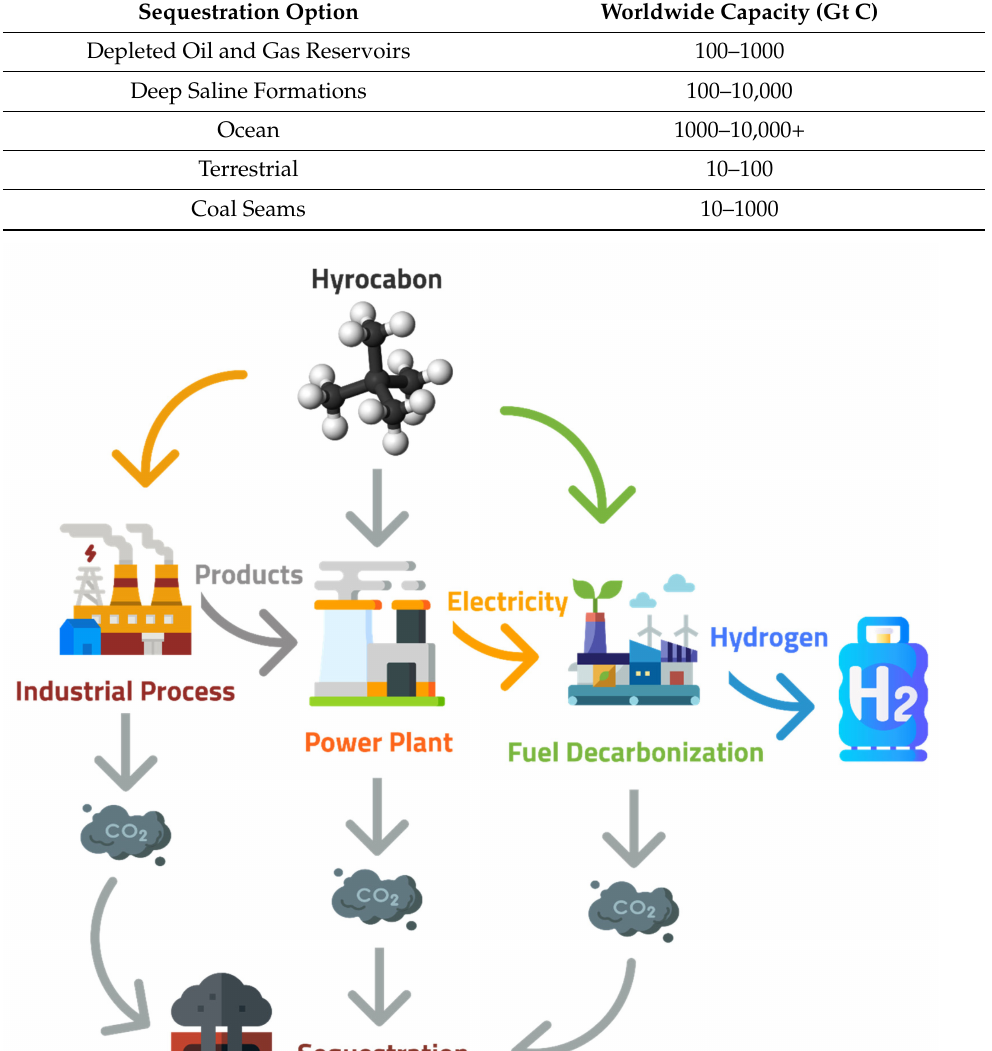
Table 3. The potential CO 2 storage capacity of worldwide reservoirs, reprinted with permission from Ref. [58]. Copyright 2022 Elsevier.